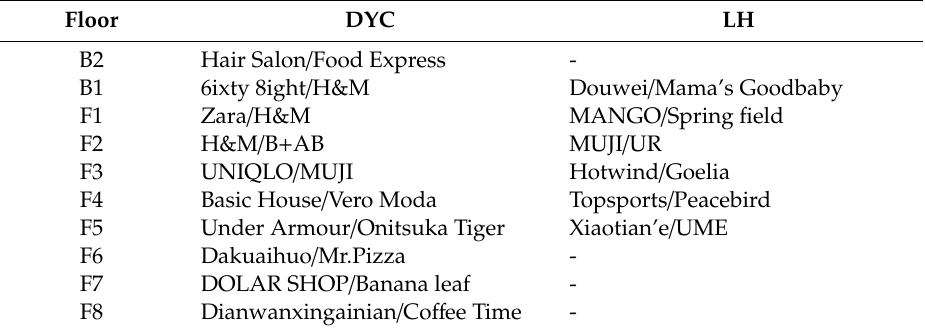
Table 6. Anchor stores in two shopping